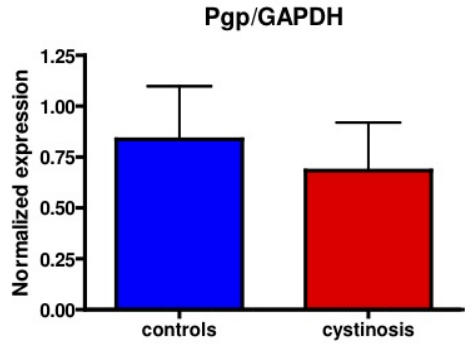
Figure 2. Mean relative protein expression (P-gp/GAPDH) measured by Western blotting in ciPTEC of cystinosis patients (red bar) compared to controls (blue bar). p =